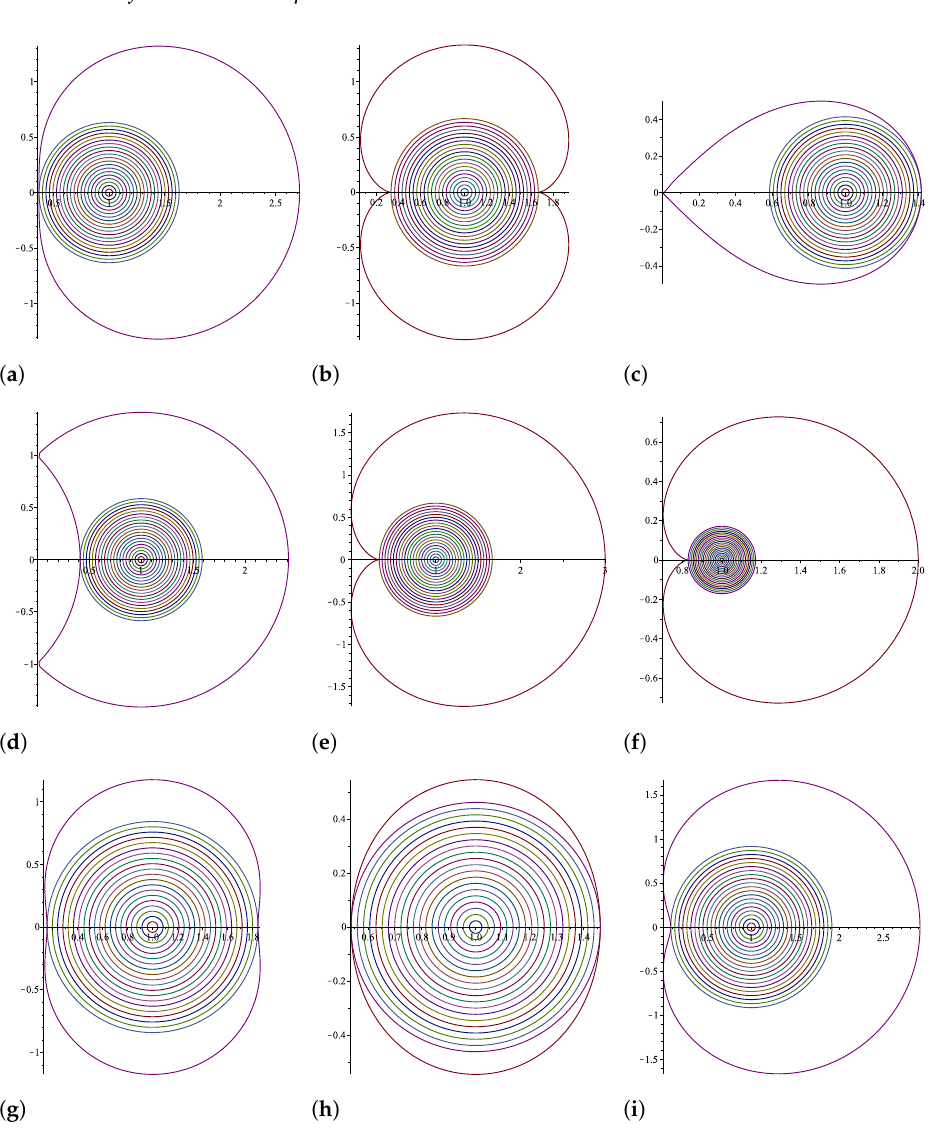
Figure 1. Figures for the Theorem 1. ( a ) Boundary curve of ψ ( D ) and q M ( D ) for M = 1 − 1 ( b ) Boundary curve of ψ Ne ( D ) and q M ( D ) for M = 1 √ M = 2 − 1. ( d ) Boundary curve of ψ c ( D ) and q M ( D ) for M = 2 − and q M ( D ) for M = 2 . ( f ) Boundary curve of ψ R ( D ) and q M ( D ) for M = 1 3 of ψ sin ( D ) and q M ( D ) for M = sin1. ( h ) Boundary curve of ψ sig ( D ) and q M ( D ) for M = e − 1 ( i ) Boundary curve of ψ lim ( D ) and q M ( D ) for M =